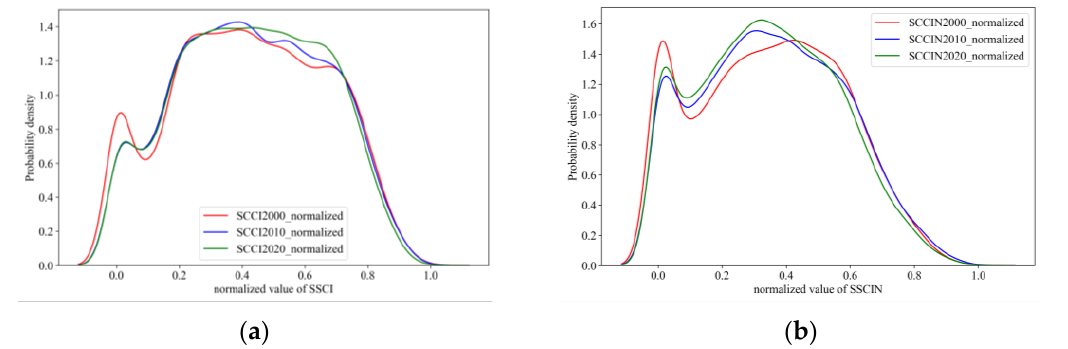
Figure 6. Probability density diagram of land-use conflict index based on the landscape ecological risk index, ( a ) with traditional measures and ( b ) with newly constructed index not considering the vulnerability index.